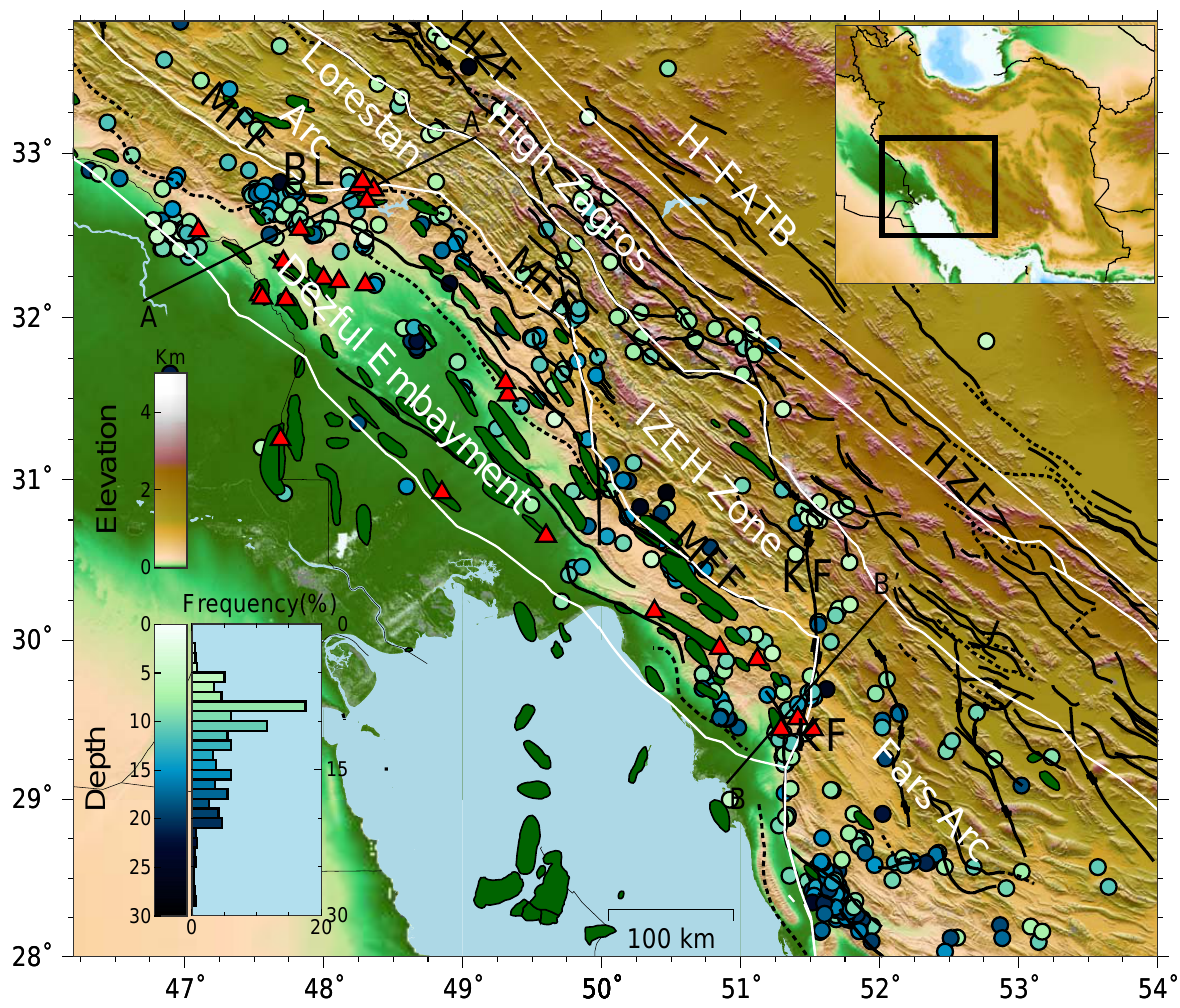
Figure 1. Topographic, structural and seismicity map of Zagros Fold and Thrust Belt along with locations of hydrocarbon fields (green oval shapes). Colored circles are IRSC-recorded earthquake centroid depths since 2010. Details of each earthquake are provided in Yaghoubi (2020). The bottom left histogram shows the depth (km) distribution of earthquakes. Red triangles denote the location of the 25 wells investigated in this study. Fault traces (the solid black lines) are inferred and compiled from Berberian (1995) and Talebian & Jackson (2004). The white lines show the main structural subdivisions of the ZFTB. Major active faults are the HZF, High Zagros Fault; KZ, Kazerun Fault System; MFF, Mountain Front Fault; MRF, Main Recent Fault; MZRF, Main Zagros Reverse Fault; ZFF, Zagros Foredeep Fault; BL, Balarud